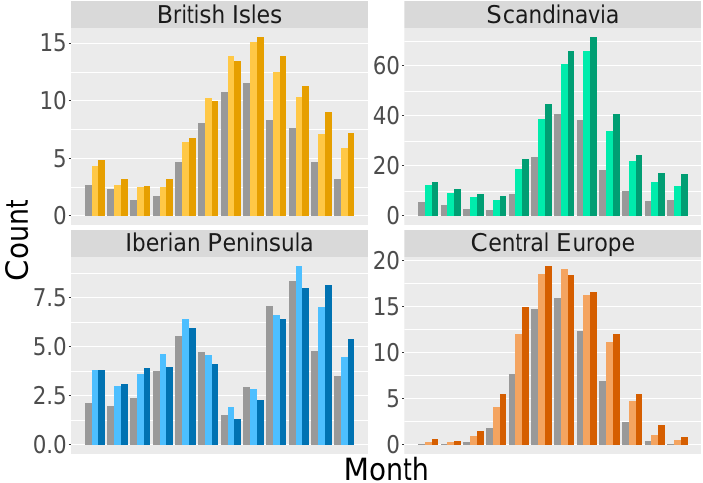
Figure 10. Seasonal cycle of detected sub-daily heavy precipitation events in four different European regions (British Isles, Iberian Peninsula, Scandinavia and Central Europe). The ensemble mean for the historical simulation (grey), the RCP4.5 (light colour) and the RCP8.5 (bright colour) scenario simulation for the period 2071–2100 are